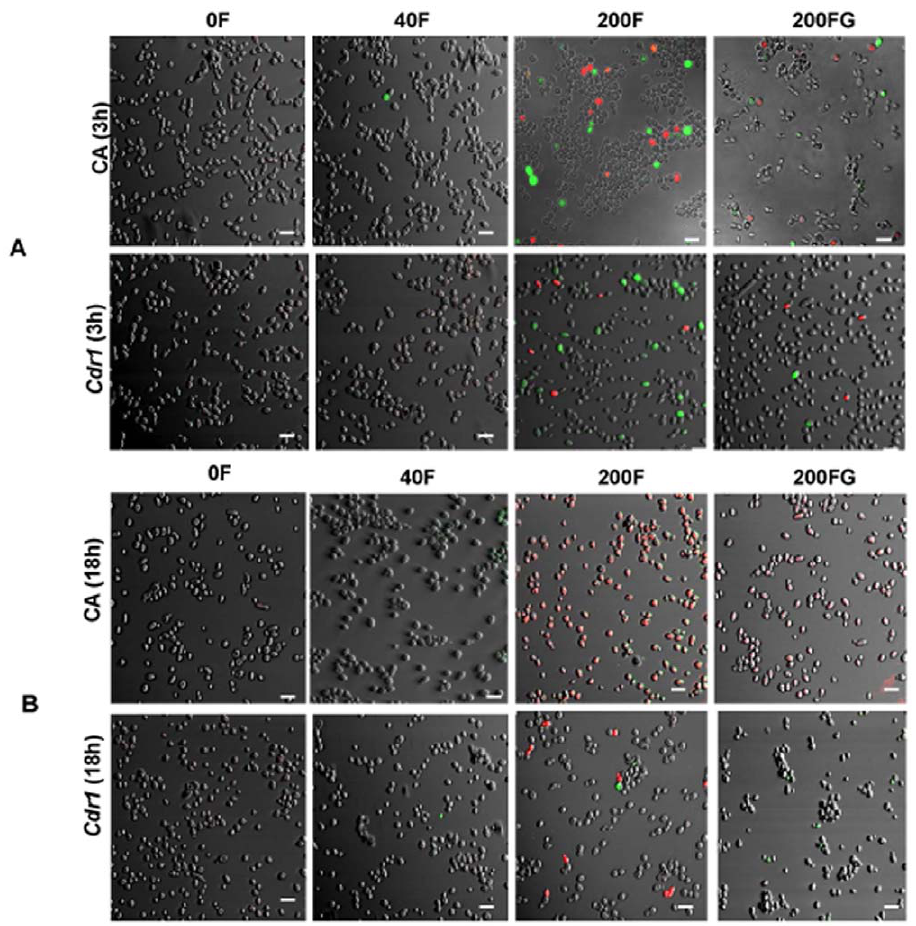
Figure 5. Representative confocal scanning laser fluorescent images of CA and cdr1 cells stained for ROS accumulation and necrosis following exposure to 40 and 200 m M farnesol in the absence (F) and presence (FG) of exogenous glutathione. ( A ) Minimal green (ROS accumulation) and red (dead) fluorescence is seen in CA and cdr1 following 3 h exposure to farnesol whereas ( B ) the majority of CA cells were red following 18 h exposure with significant decrease in fluorescence seen upon exogenous glutathione supplementation). In contrast, minimal fluorescence was seen in cdr1 cells at 18 h. Bar represents 20 m m. p , 0.05.